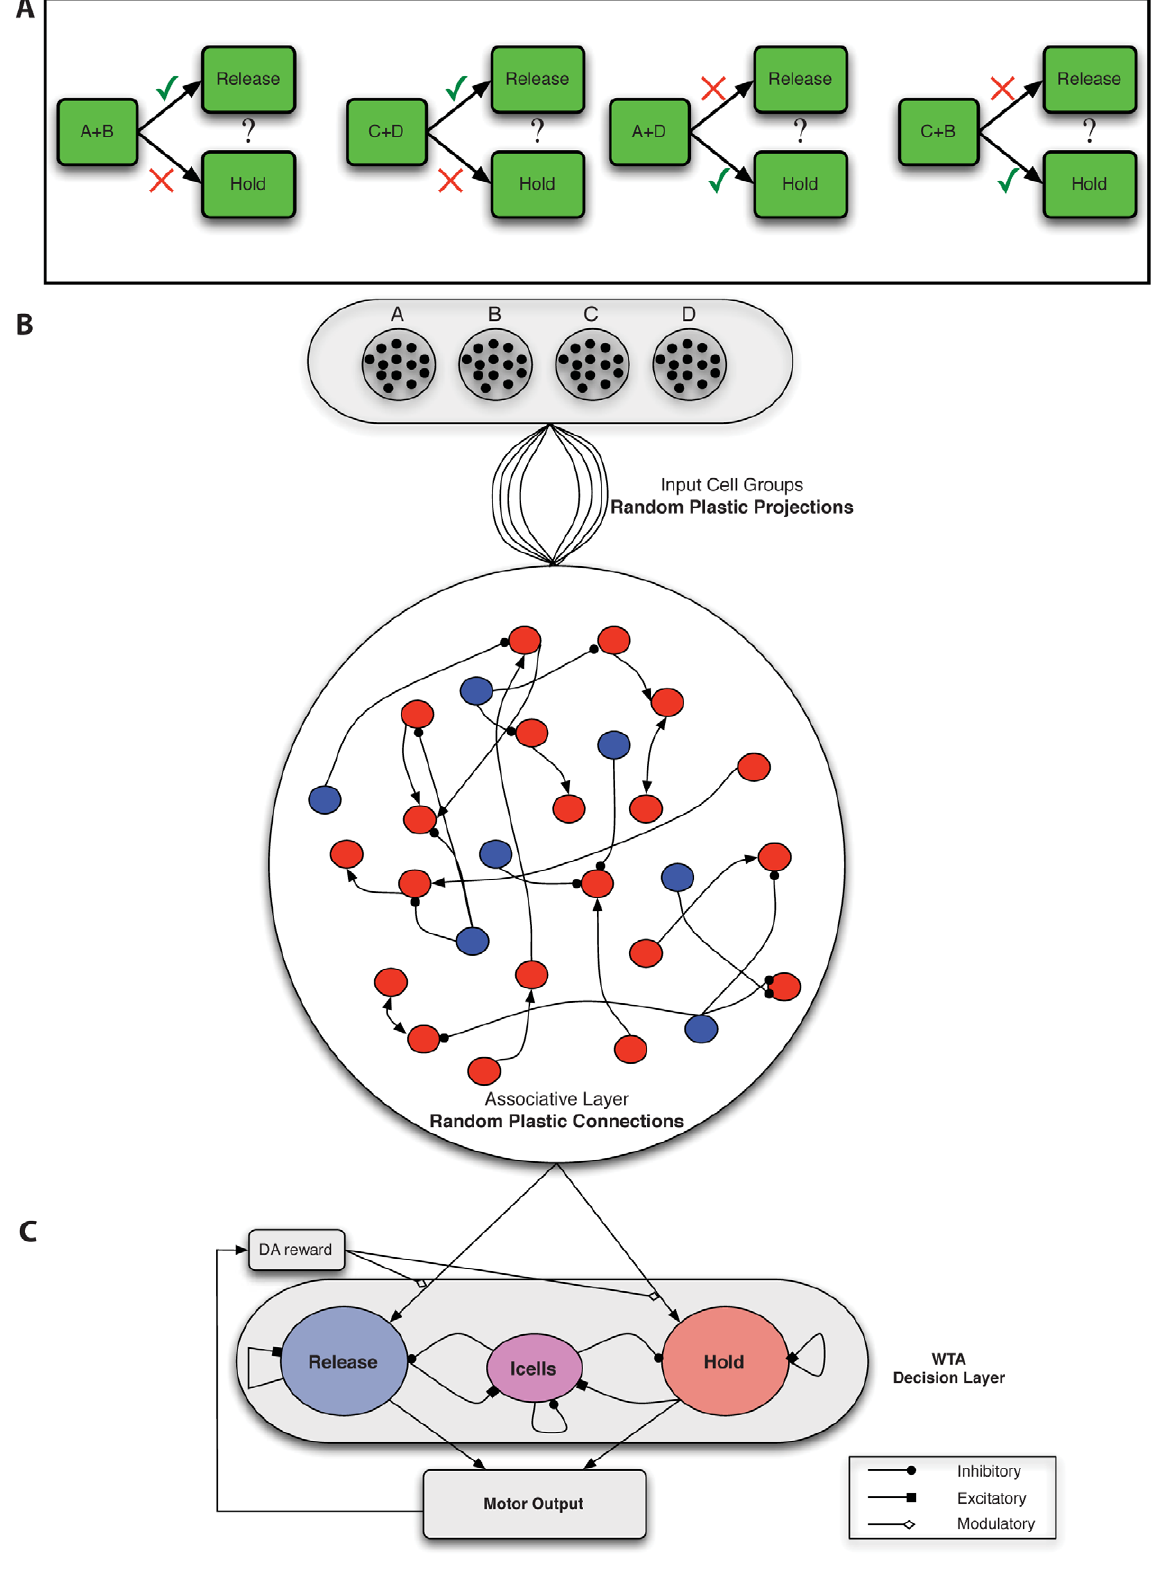
Figure 1. Biconditional discrimination task logic and network architecture. A . In an example of this task, two of four possible stimuli (A, B, C and D) are presented simultaneously to a subject [9]. If either both A and B are present or neither is present, the subject should make one response (such as release a lever). If either A or B but not both are present, the subject should make an alternative response (such as hold the lever until the end of the trial). To perform this task successfully, neurons must generate responses to specific stimulus-pairs (e.g. A + B). A response to a single